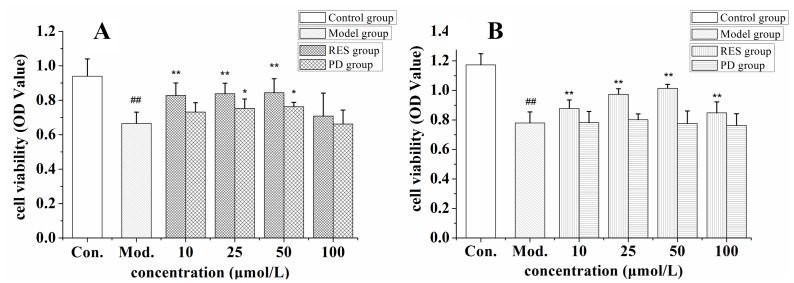
The protective effect of resveratrol (RES) and piceid (PD) on oxidation damage of HUVEC cells (panel A) and MDA-MB-231 cells (panel B) injured by 100 µmol/L hydrogen peroxide.Compared with control group (Con.), ##p<0.01; compared with model group (Mod.), *p<0.05, **p<0.01.